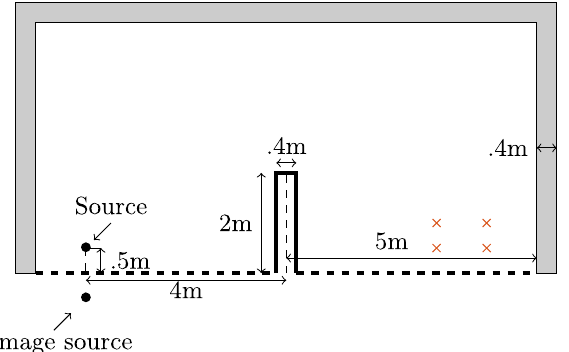
Figure 12. Sound barrier with truncated domain. White area : acoustic domain; grey area: PML domain; - - - : rigid wall, - : scattering object. Red cross: points where the error is